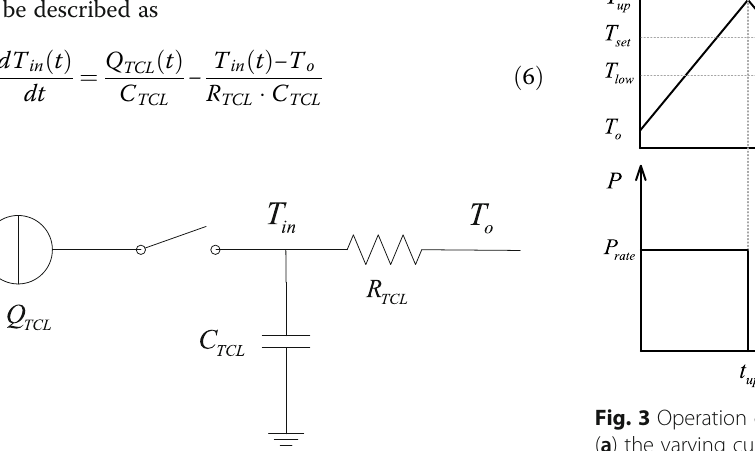
Fig. 2 First order ETP model